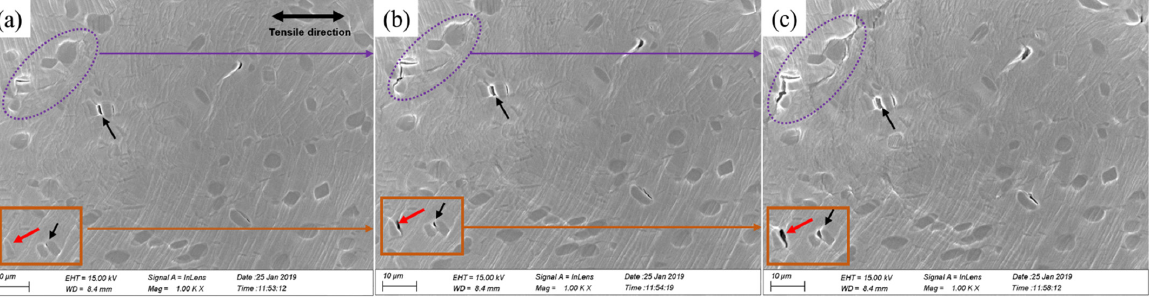
Figure 14. The SEM images during in situ tensile test according to different stages of Figure 4: ( a ) 5th, ( b ) 6th and ( c ) 7th.